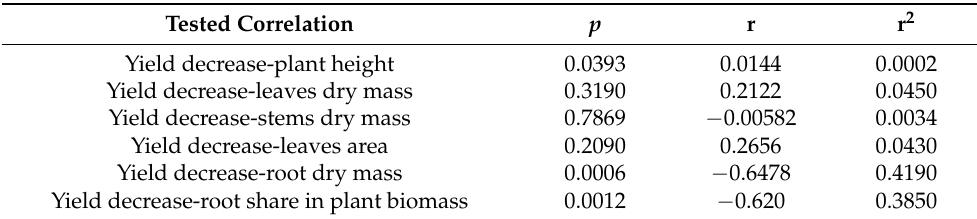
Table 3. Correlation coefficients between the selected morphological parameters of potato plant and yield decrease in relation to the control under drought stress.